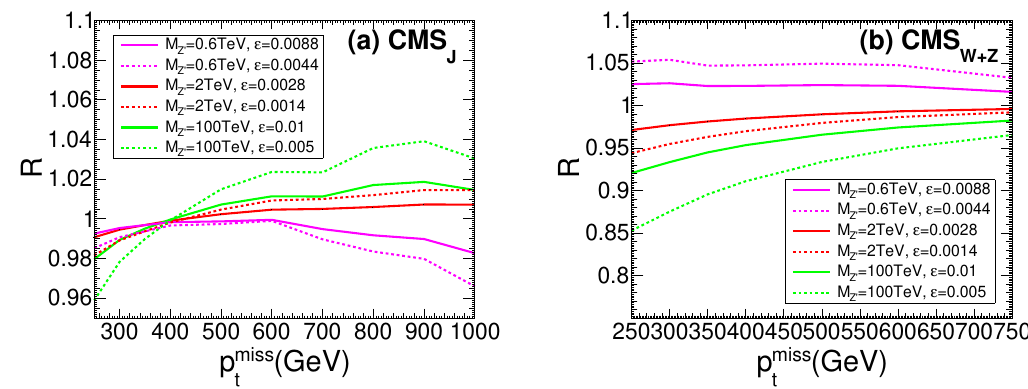
Figure 4. Ratio of predicted cross-sections without and with interference contributions, for pro- duction of CMS mono-jet and mono- W/Z on the left and right respectively. Results are shown for a few benchmark points of M Z 0 and (cid:15) according to current and future LHC sensitivity.